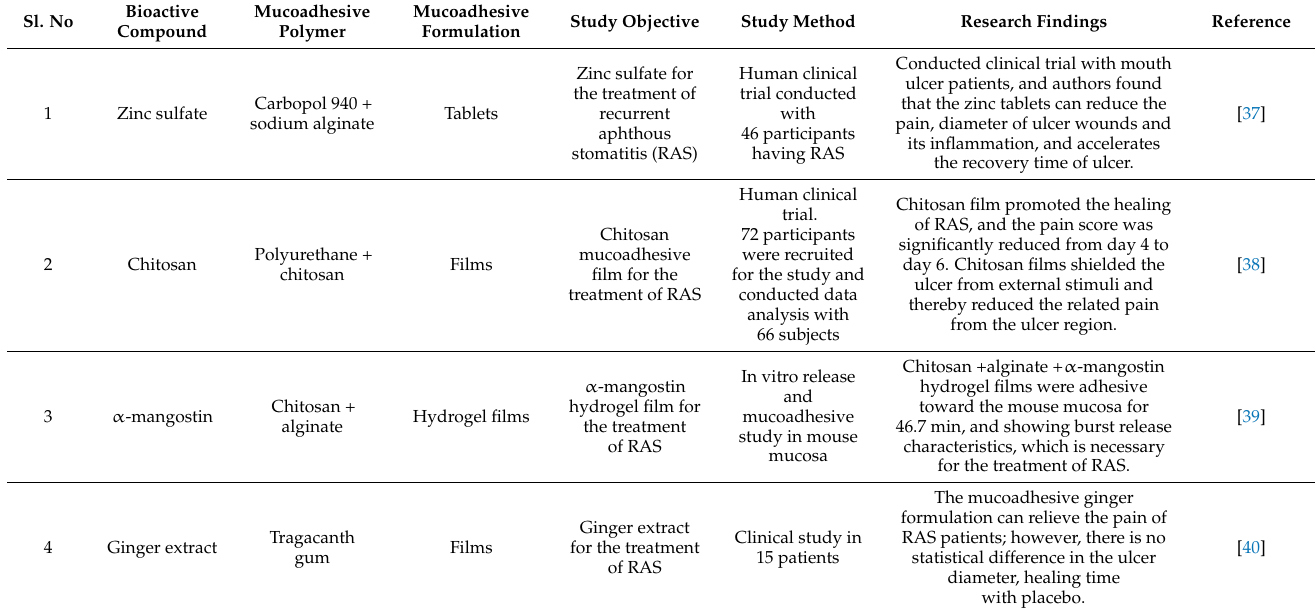
Table 3. Recent application of mucoadhesive dosage form for nutraceutical